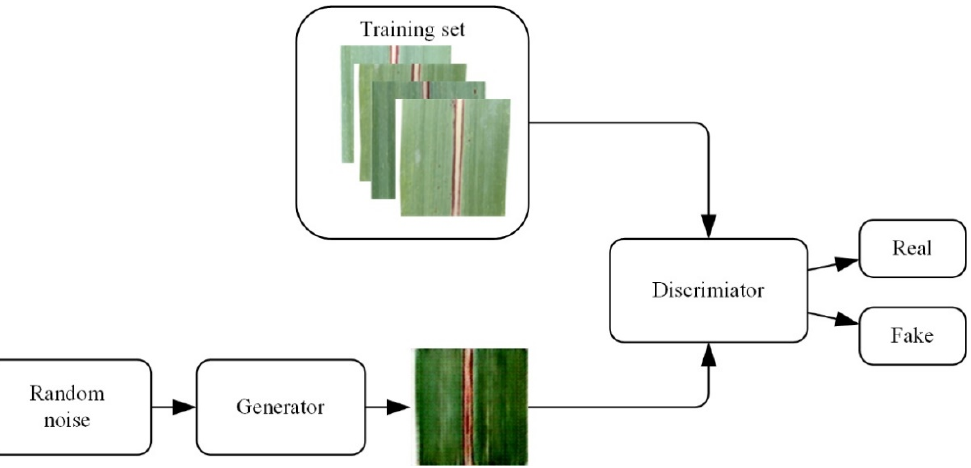
Figure 4. GAN network block structure.